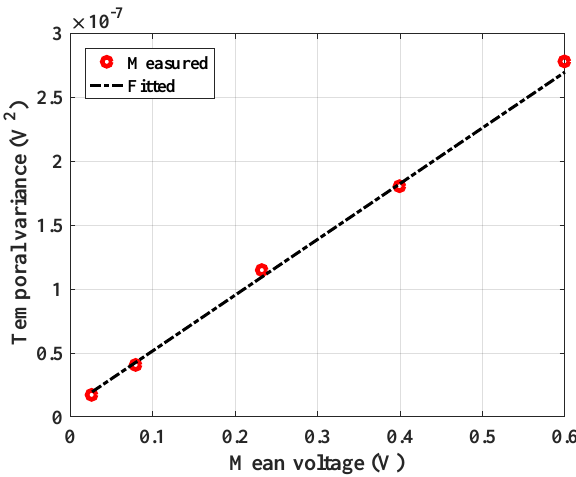
Figure 13. Temporal variance versus mean output voltage extracted from